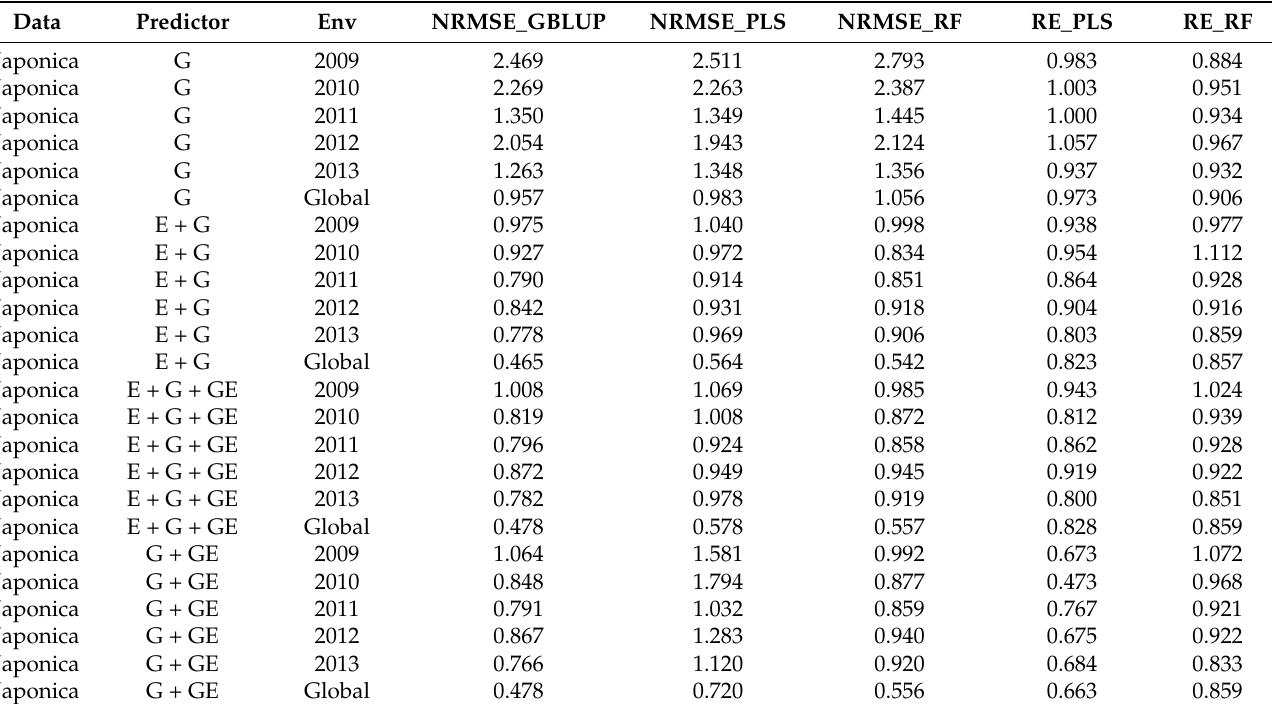
Table 4. Prediction performance for each environment and across environments (global) of dataset 2 (Japonica) in terms of normalized mean square error (NRMSE) and relative efficiency (RE) un- der four predictors (G, genotypic information; E + G, environment plus genotypic information; E + G + GE, environment plus genotypic plus genotype by environment interaction information; and G + GE, genotypic plus genotype by environment interaction), under sevenfold cross validation. NRMSE_GBLUP, NRMSE_PLS and NRMSE_RF denote the NRMSE under the GBLUP , PLS and random forest models, respectively. RE_PLS and RE_RF denote the relative efficiency (RE) calculated with the NRMSE of the PLS and random forest models, respectively. RE was calculated by dividing the prediction performance (with NRMSE) of the GBLUP model between the prediction performance of the PLS and random forest models; that is, the GBLUP model was considered the reference